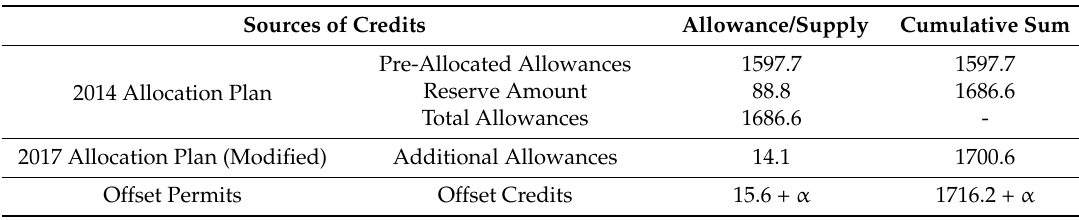
Table 4. Supply of emission permits in millions of